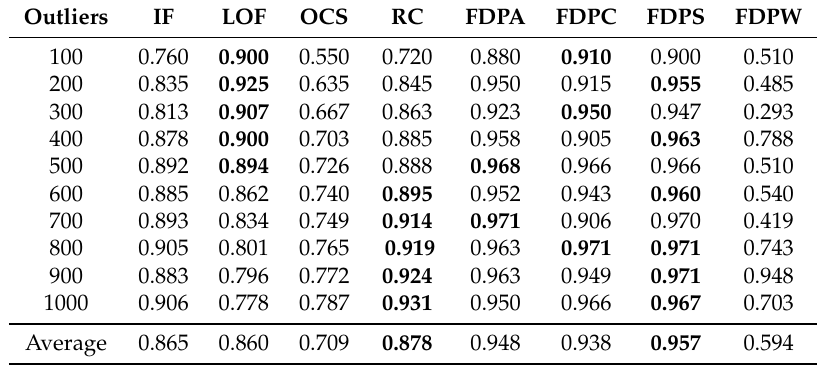
Table 5. The outlier detection rates of real-world experiments. The highest value of the FDP algorithms and the highest value of the comparison algorithms are respectively marked in bold font.